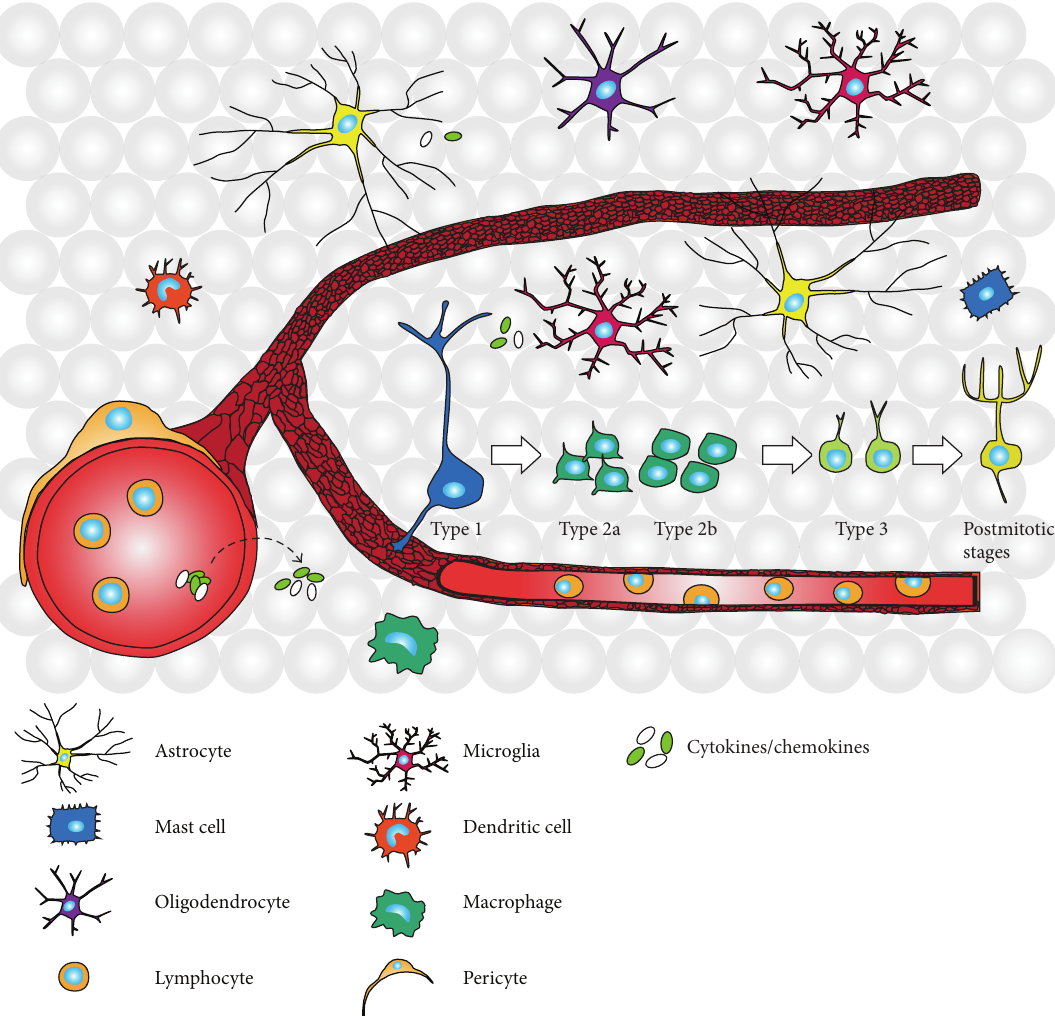
Figure 1: Neural progenitor cells and immune cells coexist in the hippocampal neurogenic niche. Type 1 neural stem cells in the subgranular zone of the hippocampal dentate gyrus mature through different developmental stages during the multistep process of new neuron formation. Type 1 radial glia-like cells give rise to transiently amplifying progenitor cells (Type 2a/Type 2b). After passing the neuronally committed Type 3 stage the cells become postmitotic after which they integrate as mature granule cells into the existing hippocampal circuitry. Within the complex niche environment peripheral and resident immune cells interact with niche cells to regulate the neurogenic process under physiological conditions. In addition, immune cells in the blood and the niche secrete immune molecules, including cytokines and chemokines, to facilitate neuroimmunological